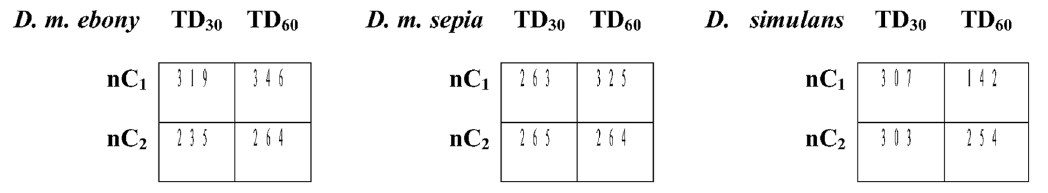
Figure 3. Schematic depiction of the experimental design used in Wallace [ 18 ] . Depicted is, for each of the three Drosophila strains, the minimum number of trials performed per combination of the whole plot factors number of cages ‘nC’ and trial duration ‘TD’. For each combination of these two factors (each cell), the same combinations of the subplot factors number of males and number of females as in Wallace ([3]; see Fig. 2) were examined.